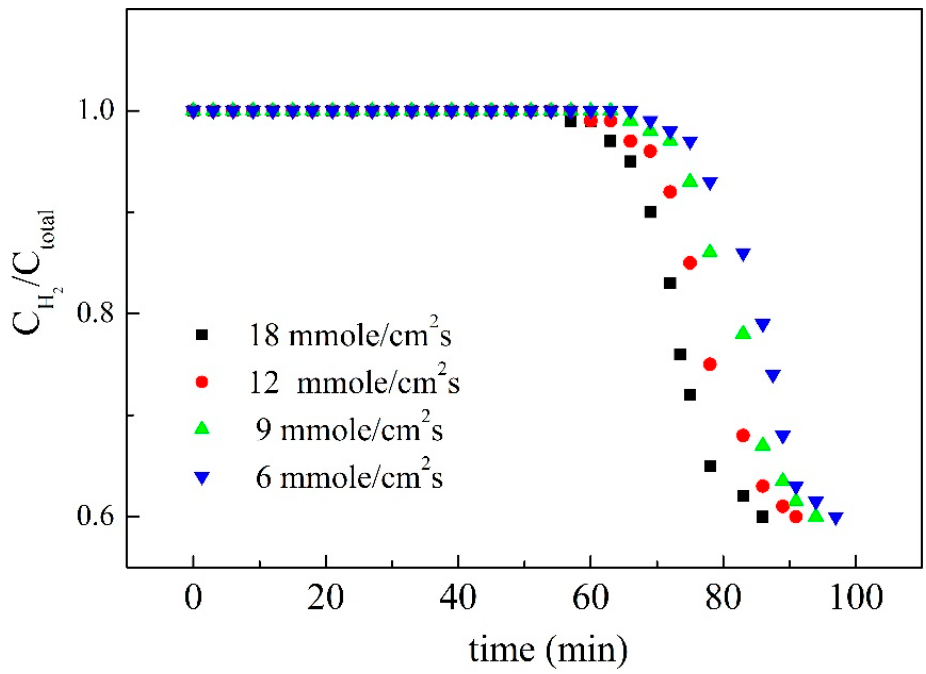
Figure 6. The effect of flow rate on the ratio of hydrogen concentration to the total concentration of gas.